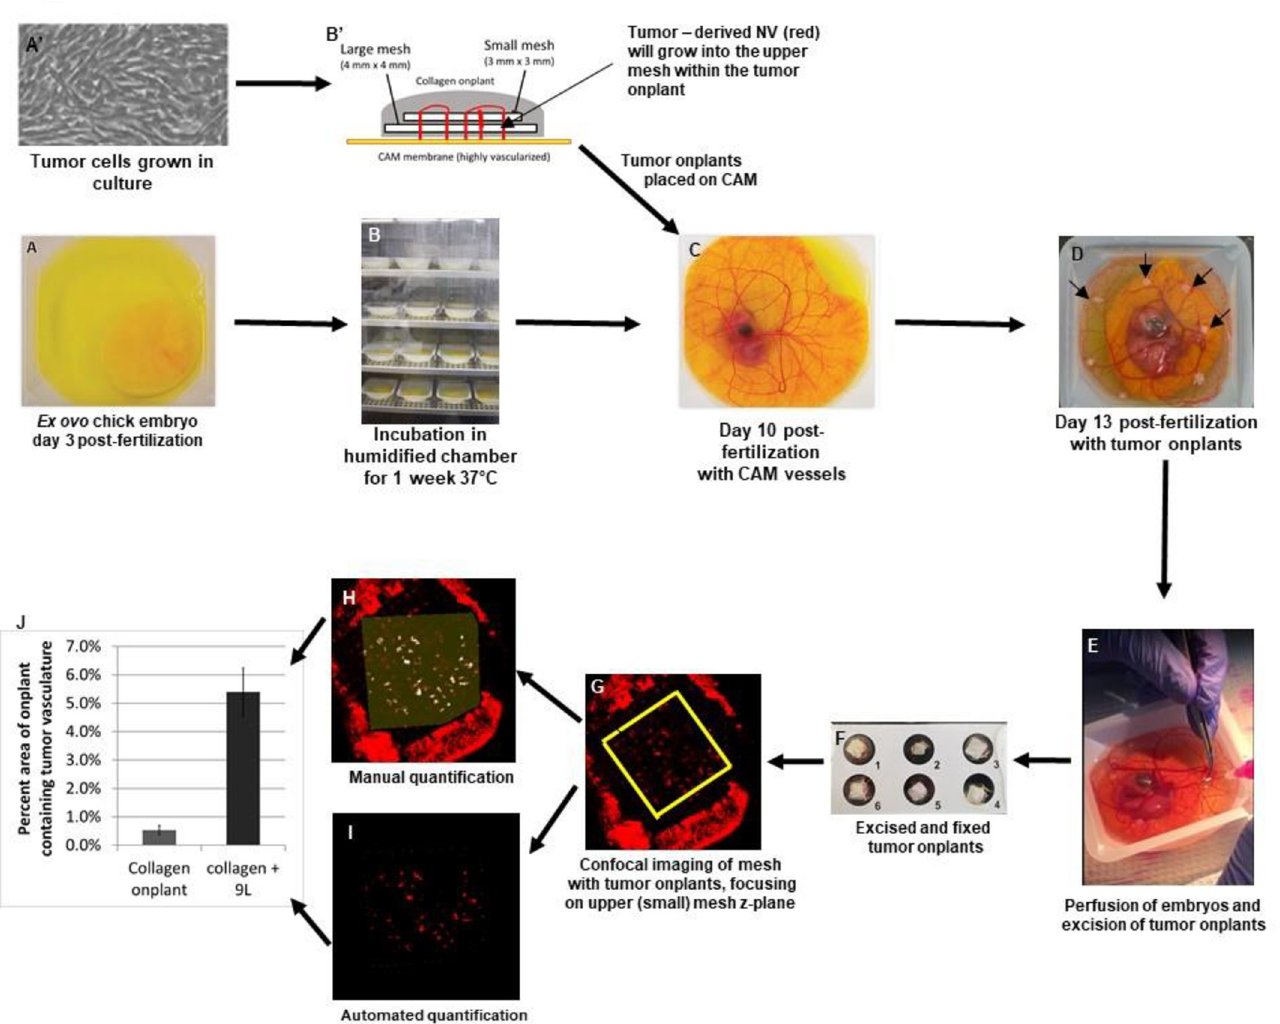
Fig 1. Description of the Ex ovo CAM model. (A) Fertilized eggs day 3 post-fertilization (3dpf) were removed from the shell and grown ex ovo . (B) Embryos were grown for an additional 7 days at 37˚C in humidified chambers. (A’) Meanwhile, tumor cells were grown in culture and then (B’) incorporated along with various drugs into 3-dimensional collagen 1 based onplants incorporating a larger and smaller mesh whereby tumor-derived NV (red lines) will sprout from the CAM vessels and branch upward into the onplant. (C) On day 10 post-fertilization, six tumor onplants were applied onto each CAM at evenly spaced intervals, using at least 5 different CAMs per group ( � 30 replicates total). (D) Image of a day 13 post-fertilization ex ovo embryo with six tumor onplants (indicated by arrows). (E) On day 13, CAM vessels were perfused with DIL, embryos were euthanized and tumor onplants were excised. (F) Excised onplants were fixed to a 6-well microscope slide and imaged using confocal microscopy (G). The area of NV within the upper mesh was then quantified manually (H) or by automated quantification (I). (J) The onplants containing tumor cells resulted in 5 – 10x the amount of quantified vasculature within the onplant compared to the negative control onplants.